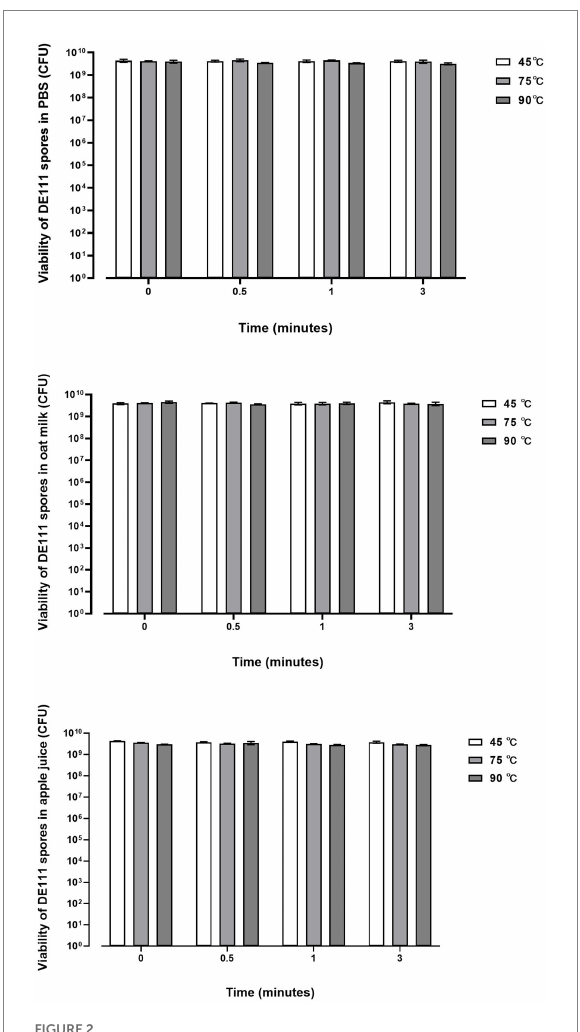
FIGURE 2 DE111 ® is resistant to temperature challenges in PBS, Oat milk and Apple juice during pasteurization process. Results show average concentration ( N = 3) ± standard